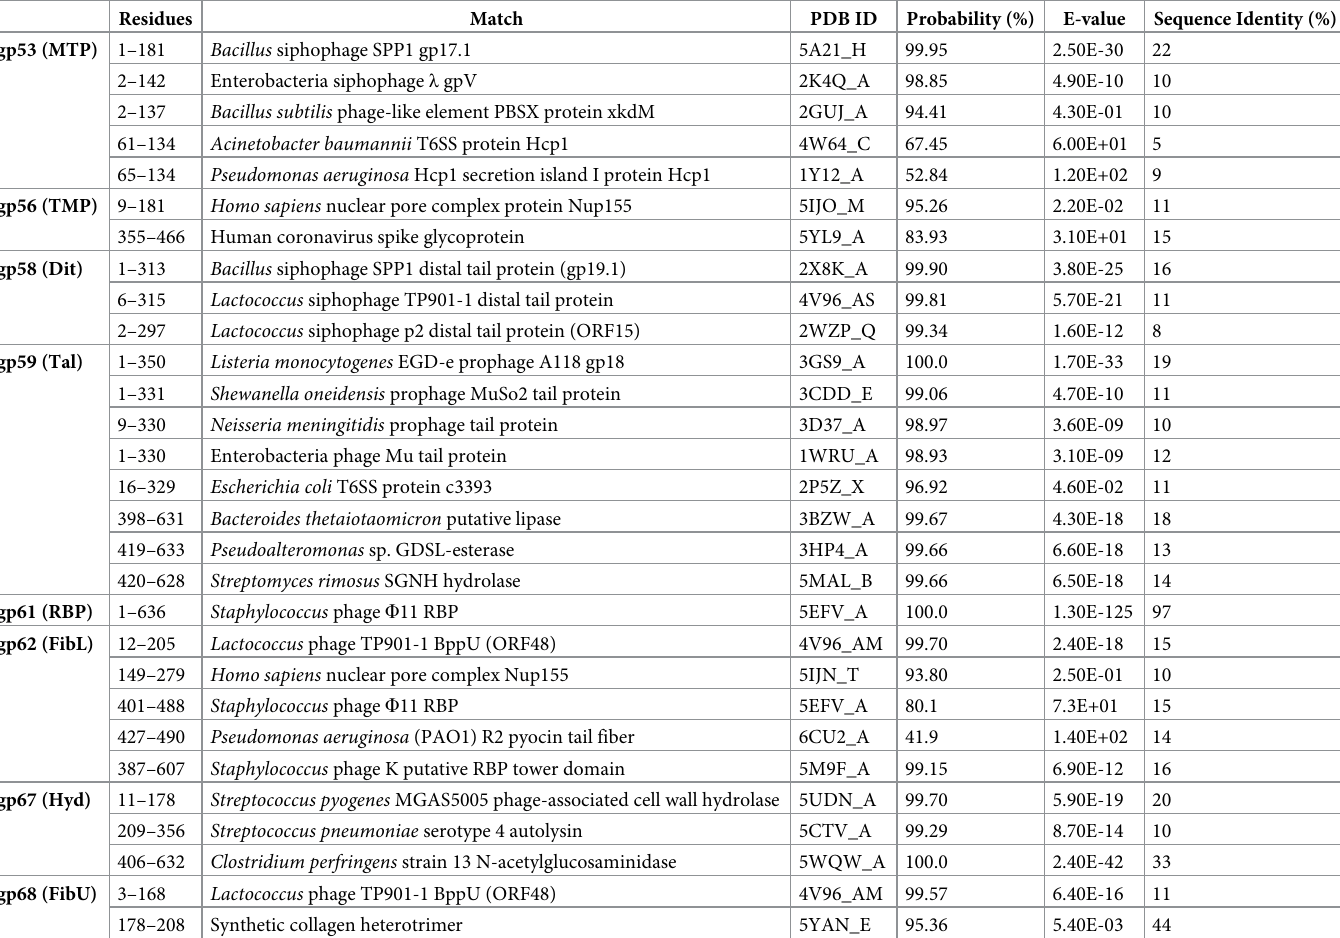
Table 2. HHpred analysis of 80 α baseplate protein sequences. The most relevant hits are shown for each protein, with matched residues, PDB ID and chain identifier, HHpred probability (%), E-value and percent sequence identity in matched region.